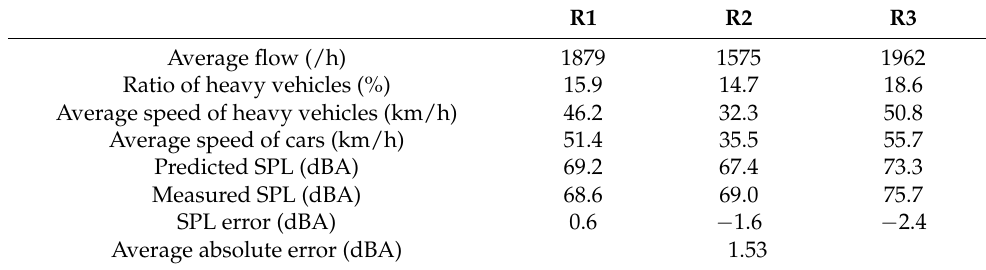
Table 3. Traffic parameters and sound pressure level in one hour for three roads.